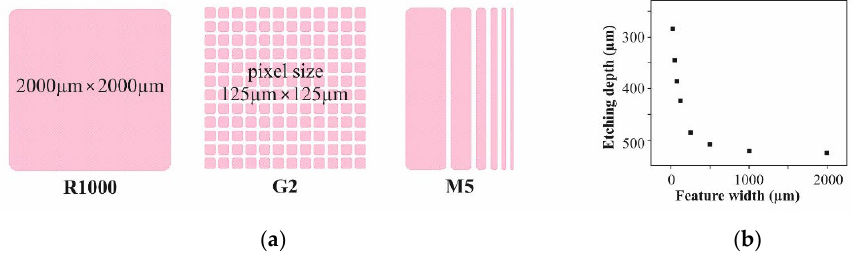
Figure 3. ( a ) Layout of the micro mold pattern used for investigations within this work. M5 com-